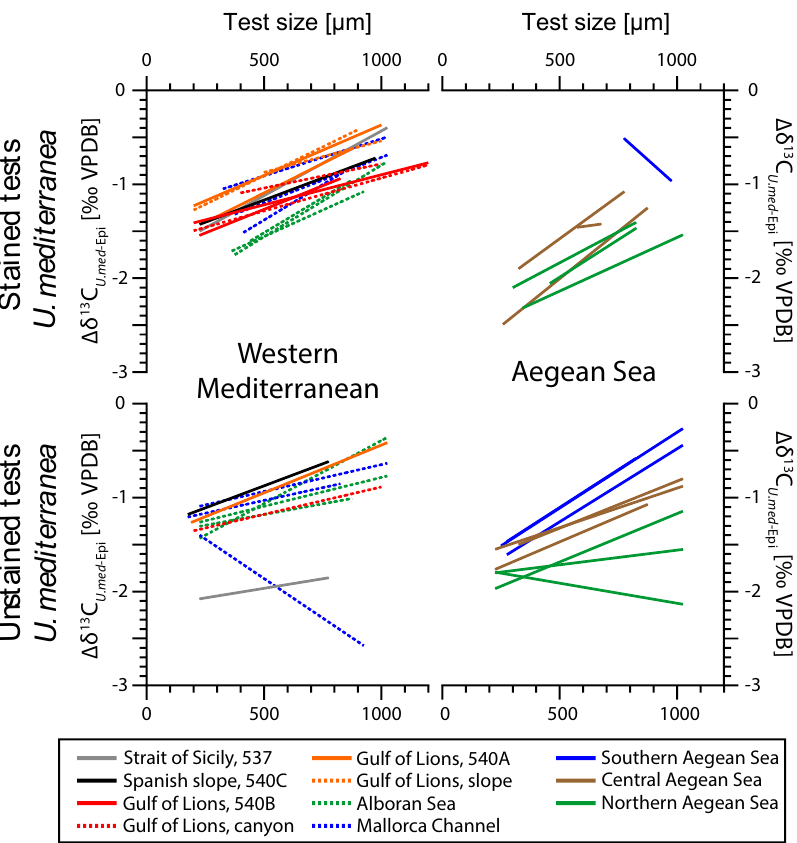
Figure 3. Correlation between δ 13 C Umed and δ 13 C Epi difference ( (cid:49)δ 13 C Umed-Epi ) and size classes of U. mediterranea . For better clarity and due to the large number of measured data (Table 1), the linear regressions for each site are given, showing clear ontogenetic trends in δ 13 C Umed due to size-independent δ 13 C Epi values. The shown data are from live (rose-bengal-stained) and dead (unstained) individuals of U. mediterranea as well as for the western Mediterranean Sea (left) and Aegean Sea (right). Dashed lines represent already published data